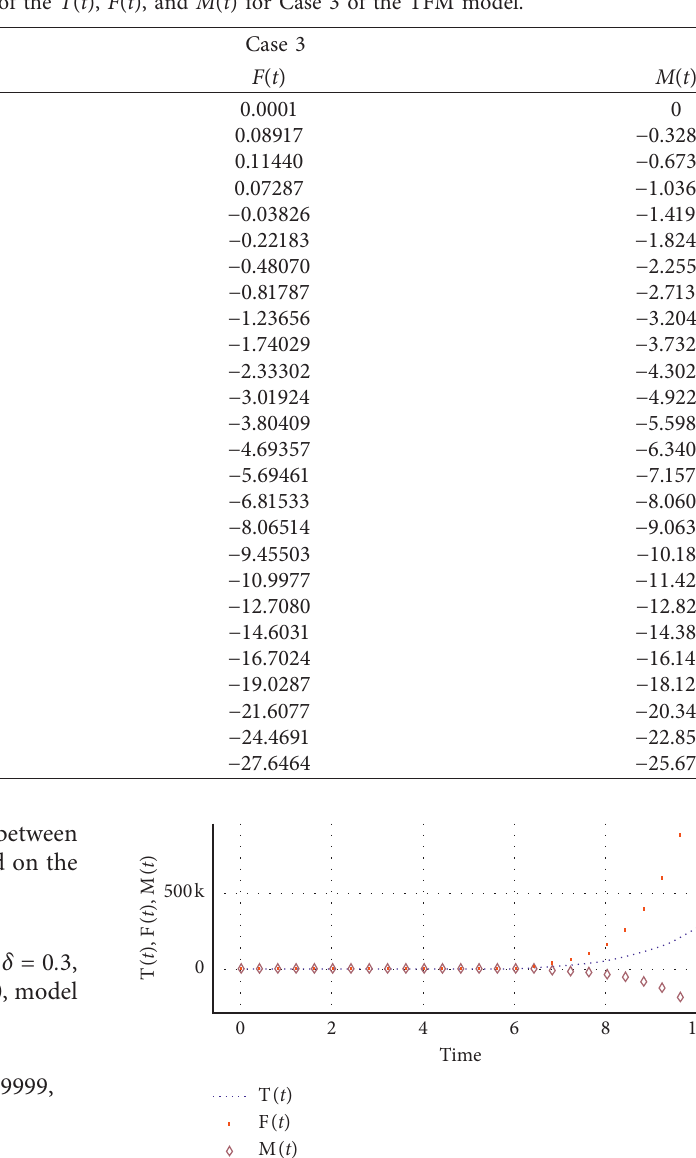
Figure 1: Nature of the T ( t ), F ( t ), and M ( t ) for Case 1 of the TFM